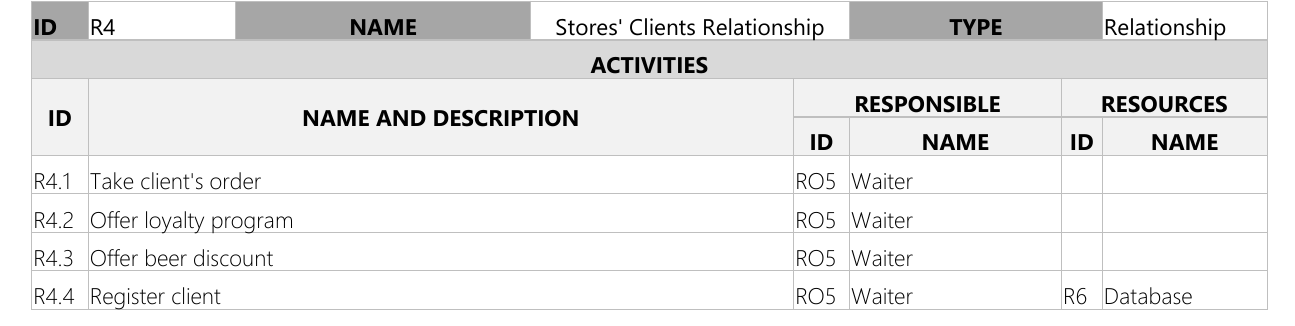
Figure 18. R4 Catalogue.